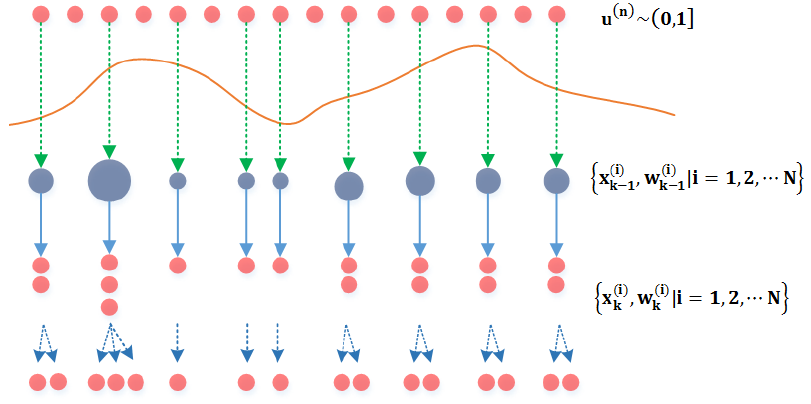
Figure 2. Principle of resampling.